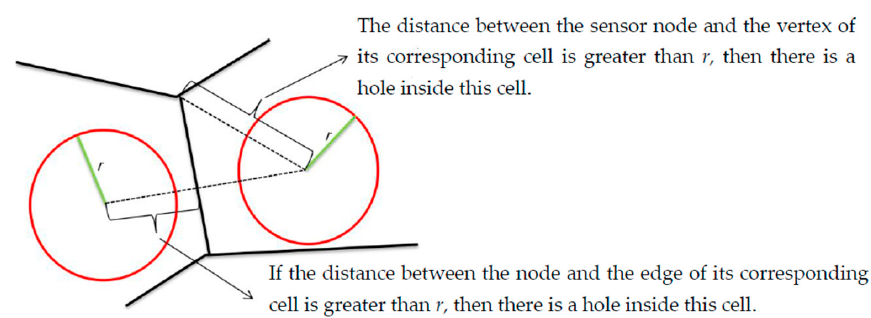
Figure 1. Coverage holes detection method.